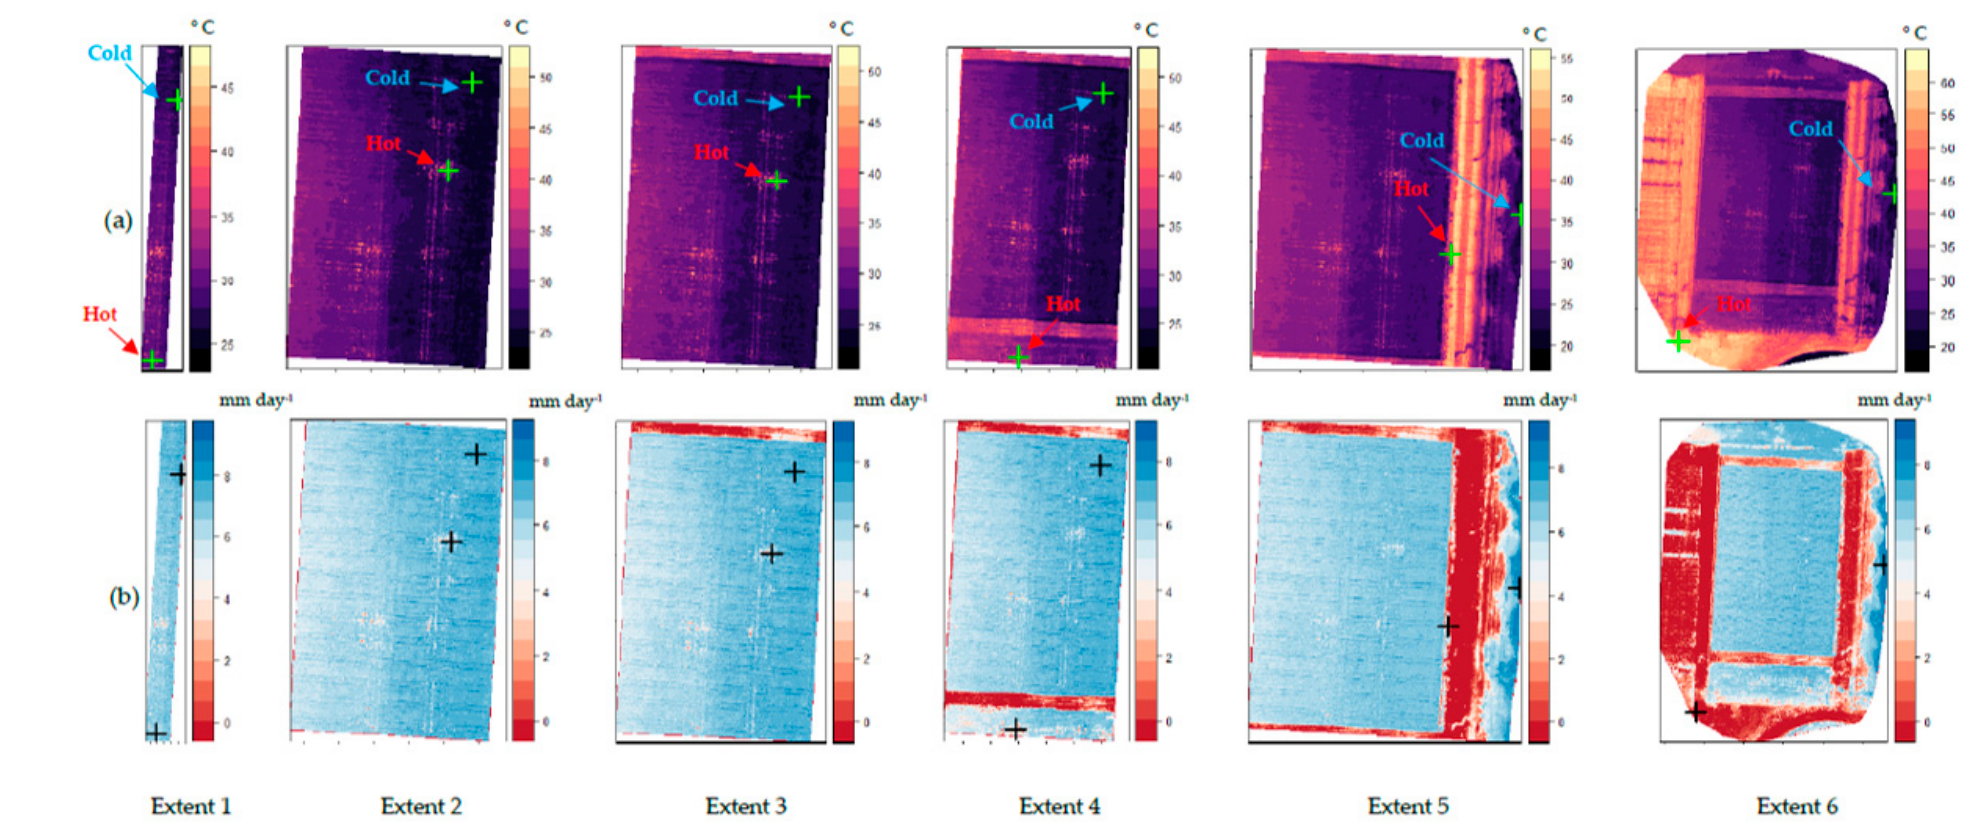
Figure 4. ( a ) An example of location of auto-selected hot and cold anchor pixels by UAS-METRIC model from different extent sizes on the thermal image on 3 August 2021. ( b ) The generated ET maps by the UAS-METRIC model of the same day (3 August 2021) with similar extent sizes with indicating the location of selected